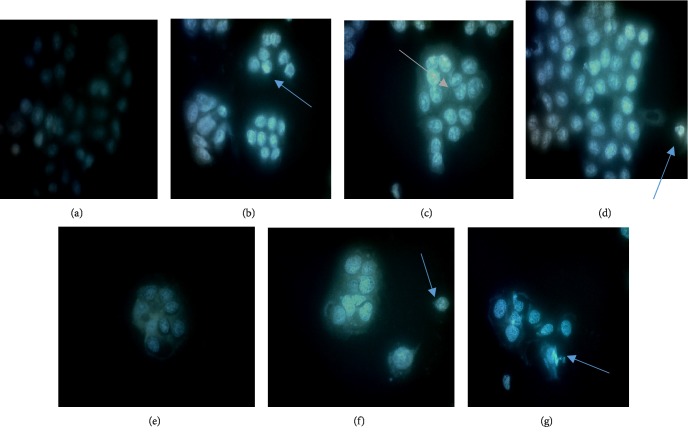
Morphological changes observed by Hoechst staining. (a) Untreated cells showed low fluorescent and normal structures. (b–d) are cells treated with 5-fluorouracil at 5, 15, and 50 µg/mL concentrations respectively. (e–g) are cells treated with methanol extract of CA at 5, 15 and 50 µg/ml concentrations respectively.